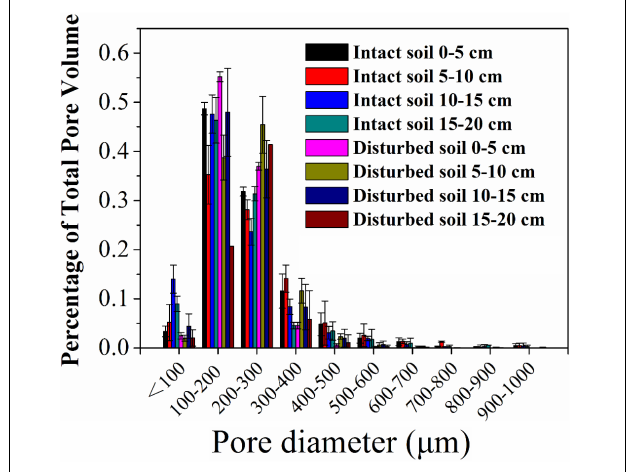
FIGURE 4 | Pore size distribution (% of total pore volume occupied by each pore class) of intact and disturbed soil cores at soil depths of 0–5, 5–10, 10–15, and 15–20